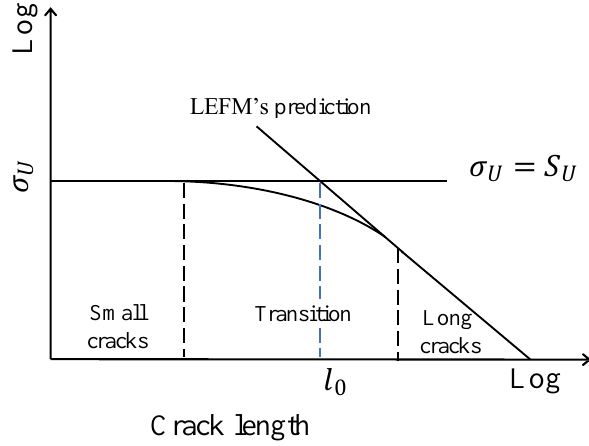
Figure 1. Schematic representation of the crack length